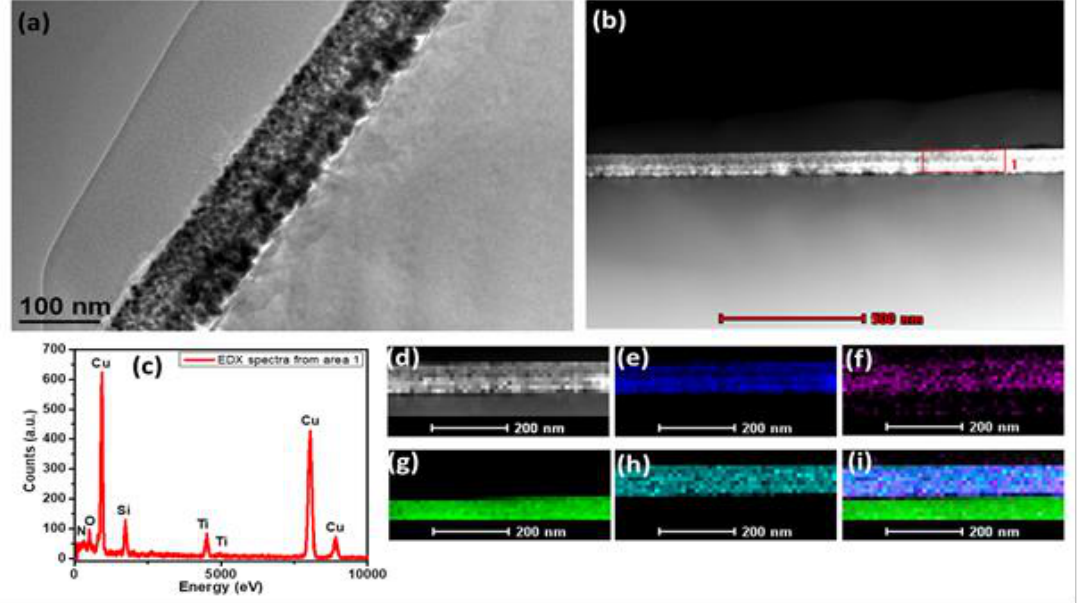
Figure 10. ( a ) Bright field TEM image, ( b ) STEM HAADF image, ( c ) EDX spectrum, ( d ) STEM image of mapping area,